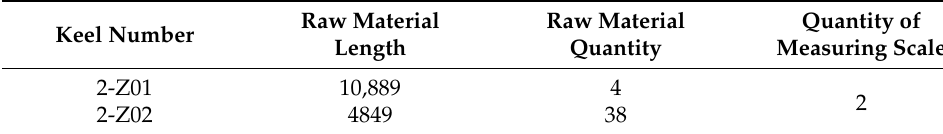
Table 2. Raw material length of the two-span and one-break main curved keel.